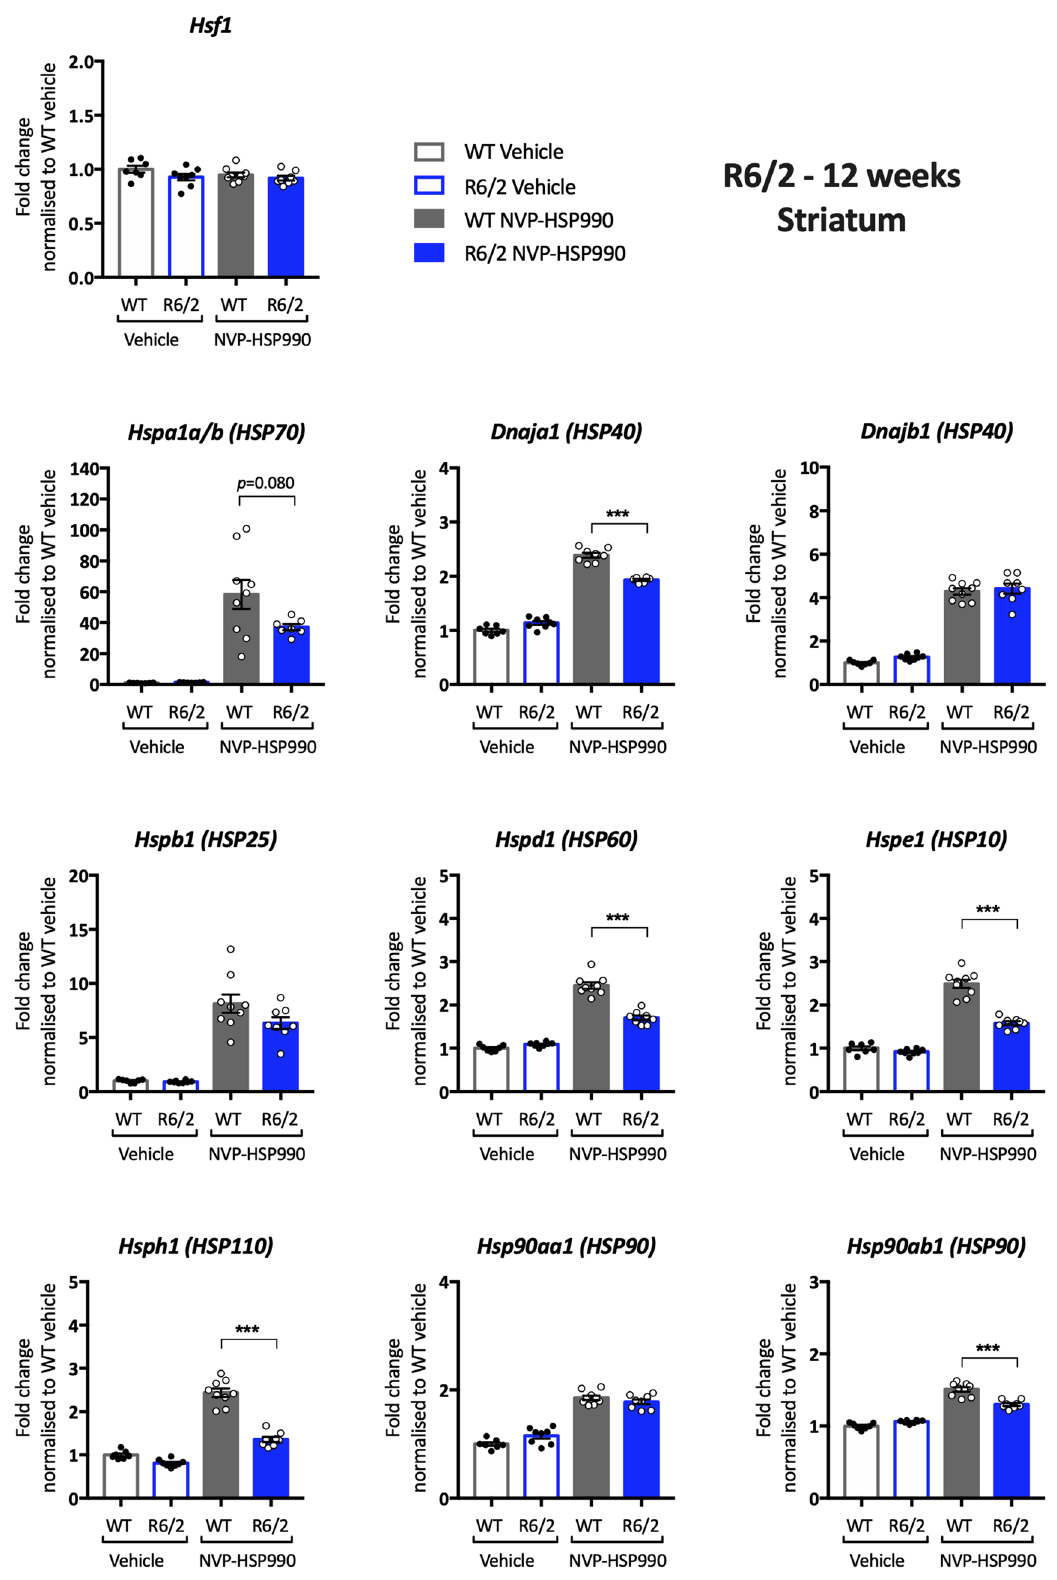
Figure 8. Analysis of the heat shock response in the striatum of R6/2 mice at 12 weeks of age. The expression of heat shock genes was measured using the QuantiGene 16-plex assay in the striatum of wild-type and R6/2 mice at 11–12 weeks of age that had been treated with vehicle or NVP-HSP990. The NVP-HSP990 treated samples were normalised to the corresponding wild-type vehicle treated samples. N = 6–9/genotype/treatment. Statistical analysis was by two-way ANOVA with Bonferroni correction for multiple comparisons. Mean ± SEM. *** p ≤ 0.001. Test statistical values can be found in Supplementary Table S15 online. WT